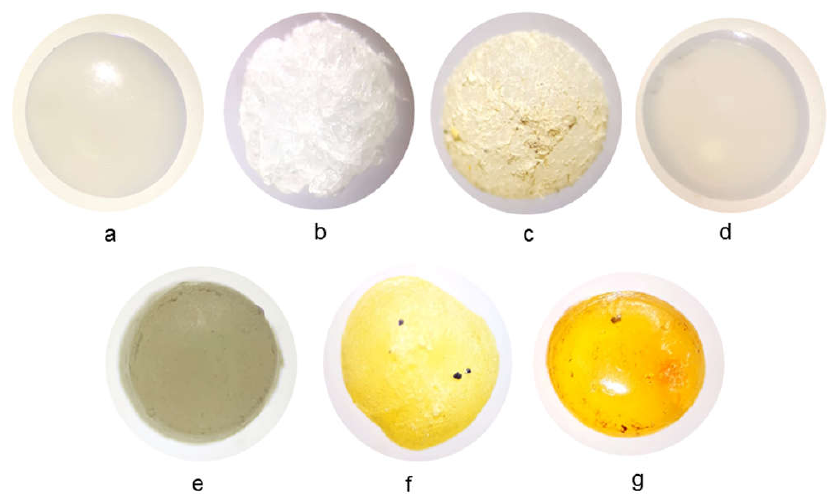
Figure 5. Images of the analyzed pellets under a binocular magnifying glass: ( a ) virgin; ( b ) virgin with high relative surface/volume by artificial friction; ( c ) virgin with high relative surface/volume by sand; ( d ) virgin with sun degradation; ( e ) marine with low YI; ( f ) marine with medium YI; ( g ) marine with higher YI.